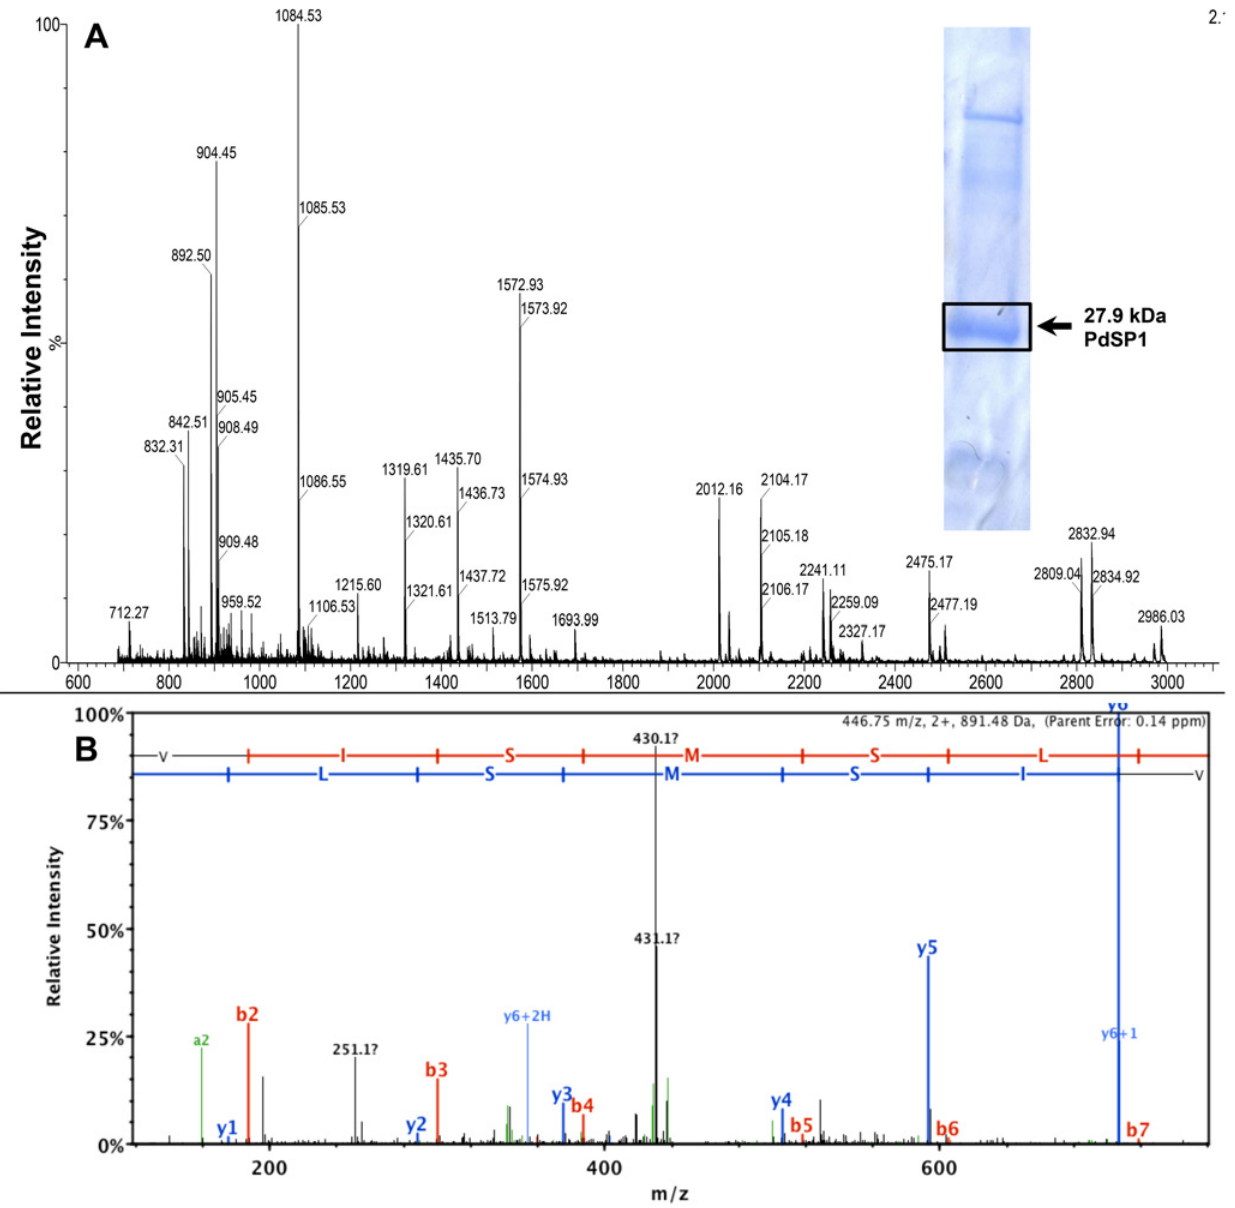
Fig 5. Peptide mass fingerprint and MS/MS spectra of PdSP1. MALDI-TOF MS spectrum ( m/z 700 – 3000) from PdSP1 tryptic peptides (A). MS/MS spectrum with b/y-series ions from peptide ion m/z 908.49 (Ox+16) (SVISMSLR)